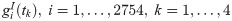
4 points based clustering.Clustering based on centered expression values giI(tk),i=1,…,2754,k=1,…,4. n
genes—number of genes in each cluster and n
TF—number of Transcription Factors in each cluster.